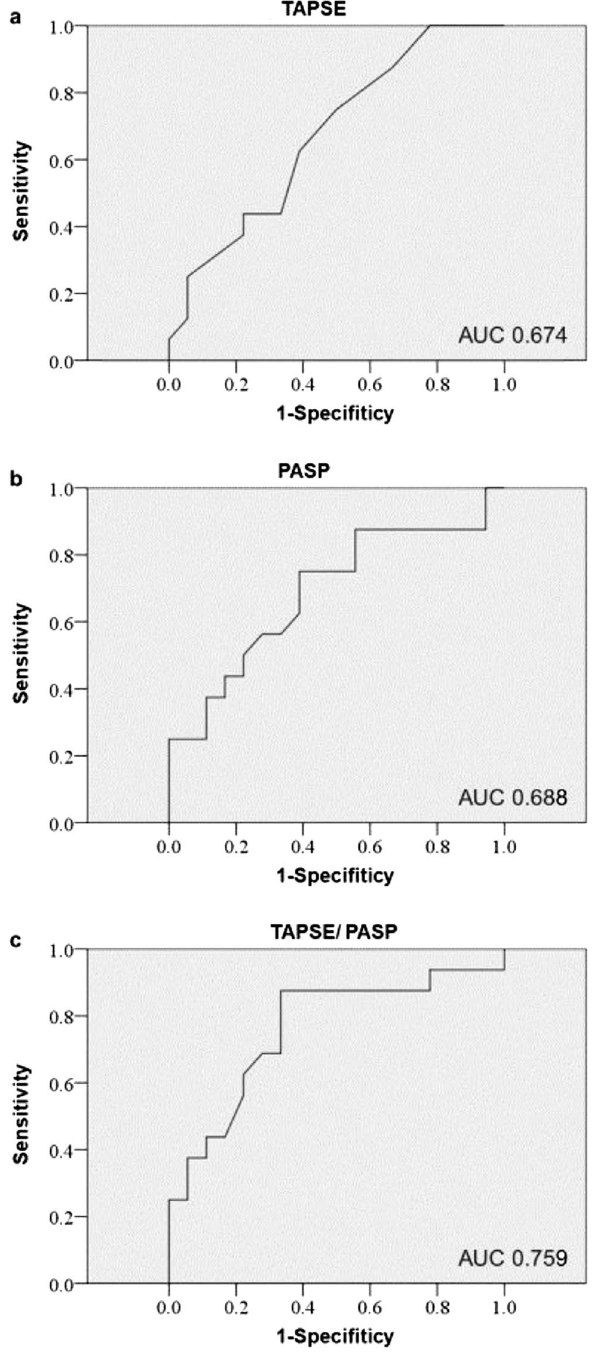
Figure 2. Receiver operating characteristic analysis on TAPSE, PASP and TAPSE/PASP at the referral time for prediction of death or need for LT. AUC area under the curve, LT lung transplantation, PASP pulmonary arterial systolic pressure, TAPSE tricuspid annular plane systolic